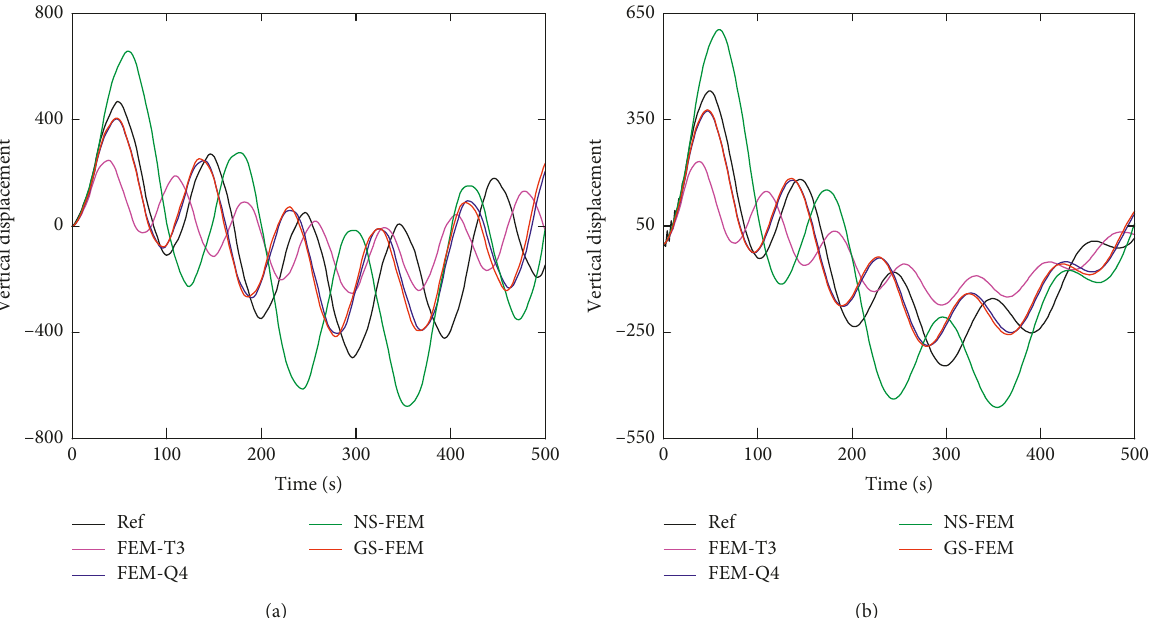
Figure 30: Transient response of the cantilever beam subjected to harmonic loading with ω